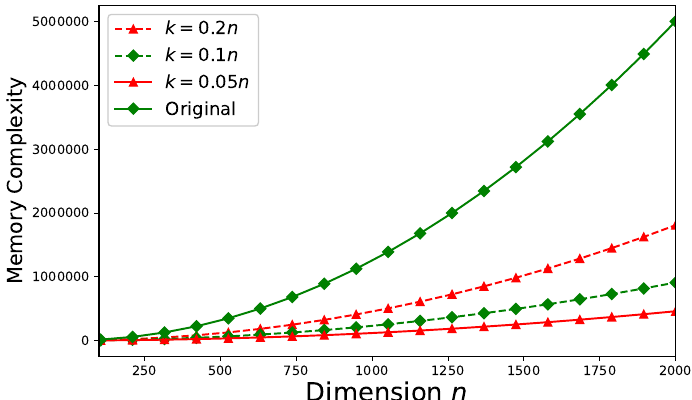
Figure 13. The memory -complexity versus n for an inconsistent system ( m = 1.25 n